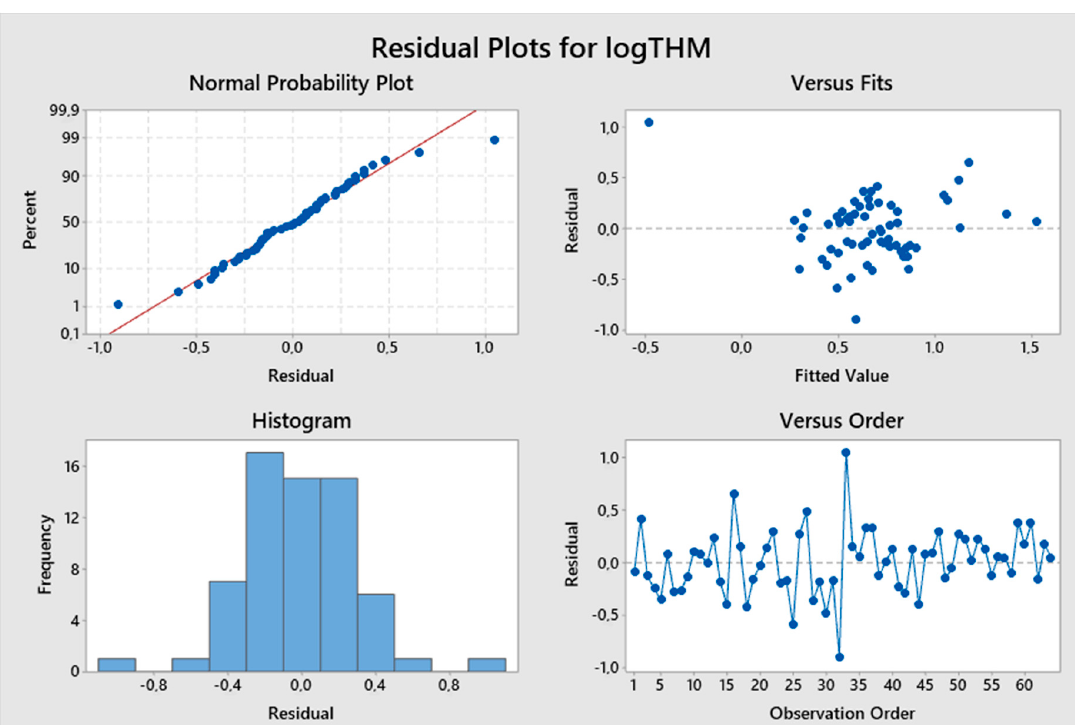
Figure 4. Residual plots for model (5).